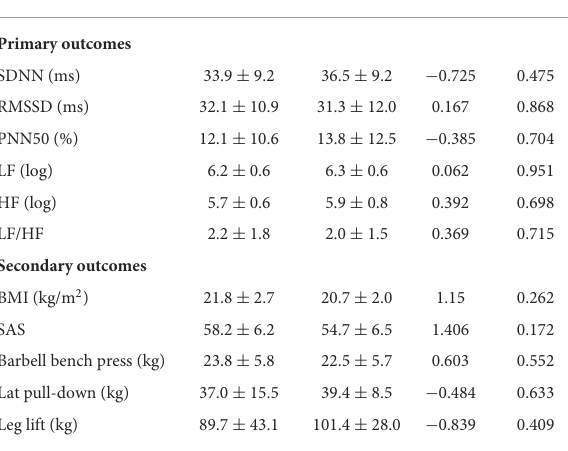
TABLE 2 Baseline primary and secondary outcomes of participants in intervention and control